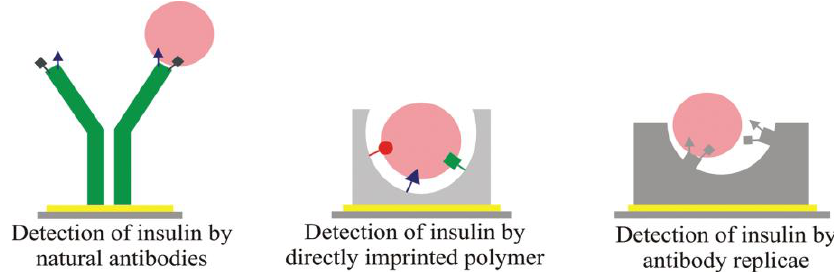
Figure 2. Different way opted for comparative studies in double imprinting. Reprinted with permission from [15], © 2012 American Chemical